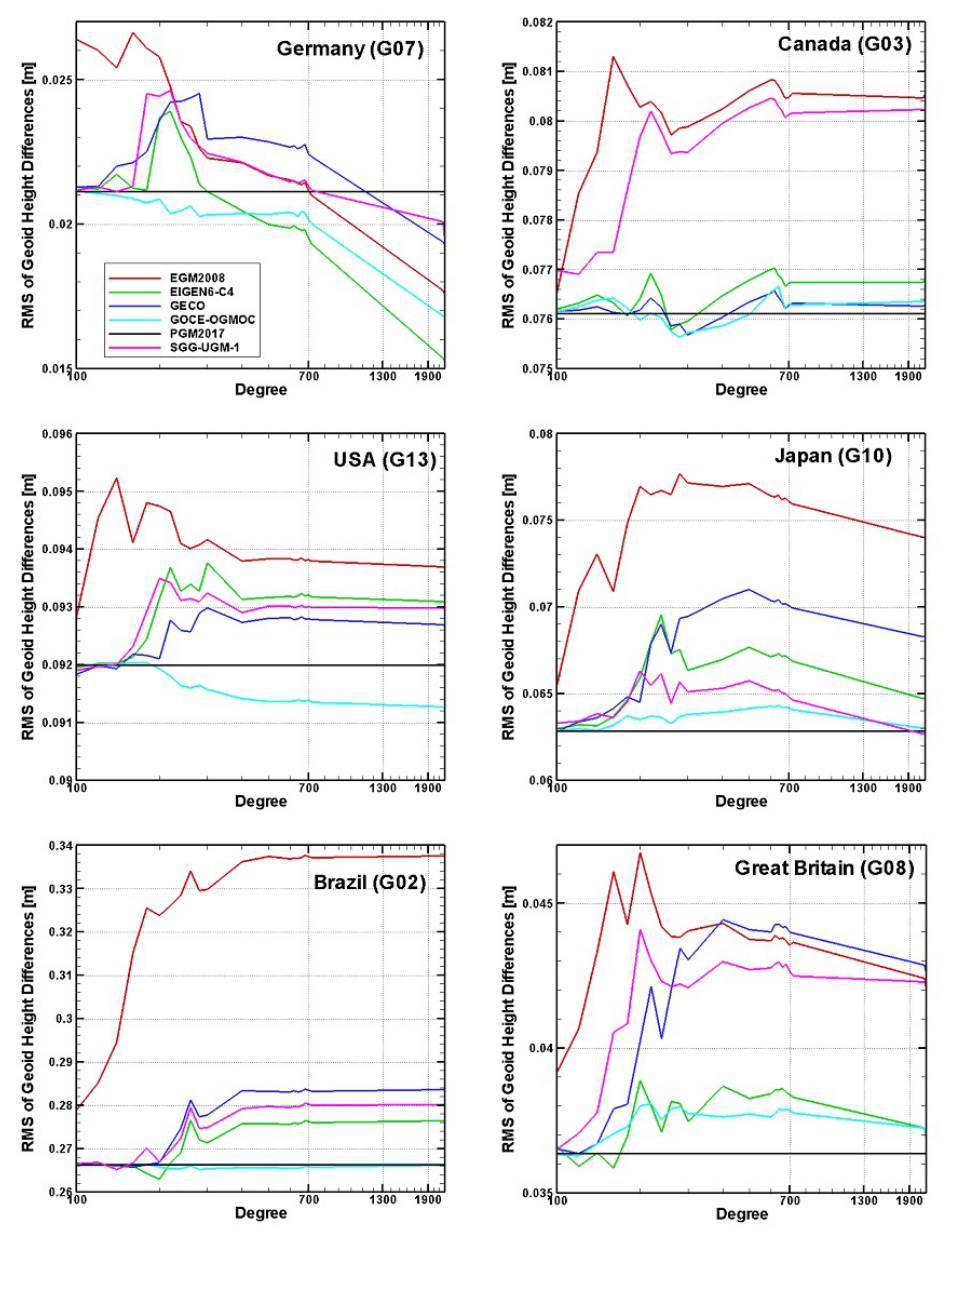
Fig. 4. RMS of geoid height differences (all in [m]) for selected regions and various truncation degrees of the global models. In all cases, the omission error was computed from the PGM2017 model and a residual topographic gravity field model. For all differences a planar correc- tion surface was computed and